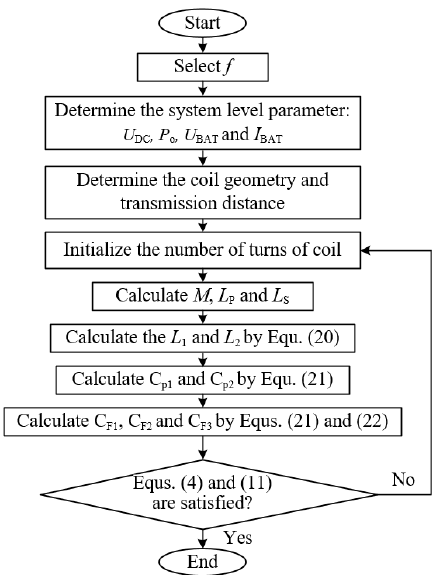
Figure 13. Flowchart for the topology parameters design of the proposed WPT charger.